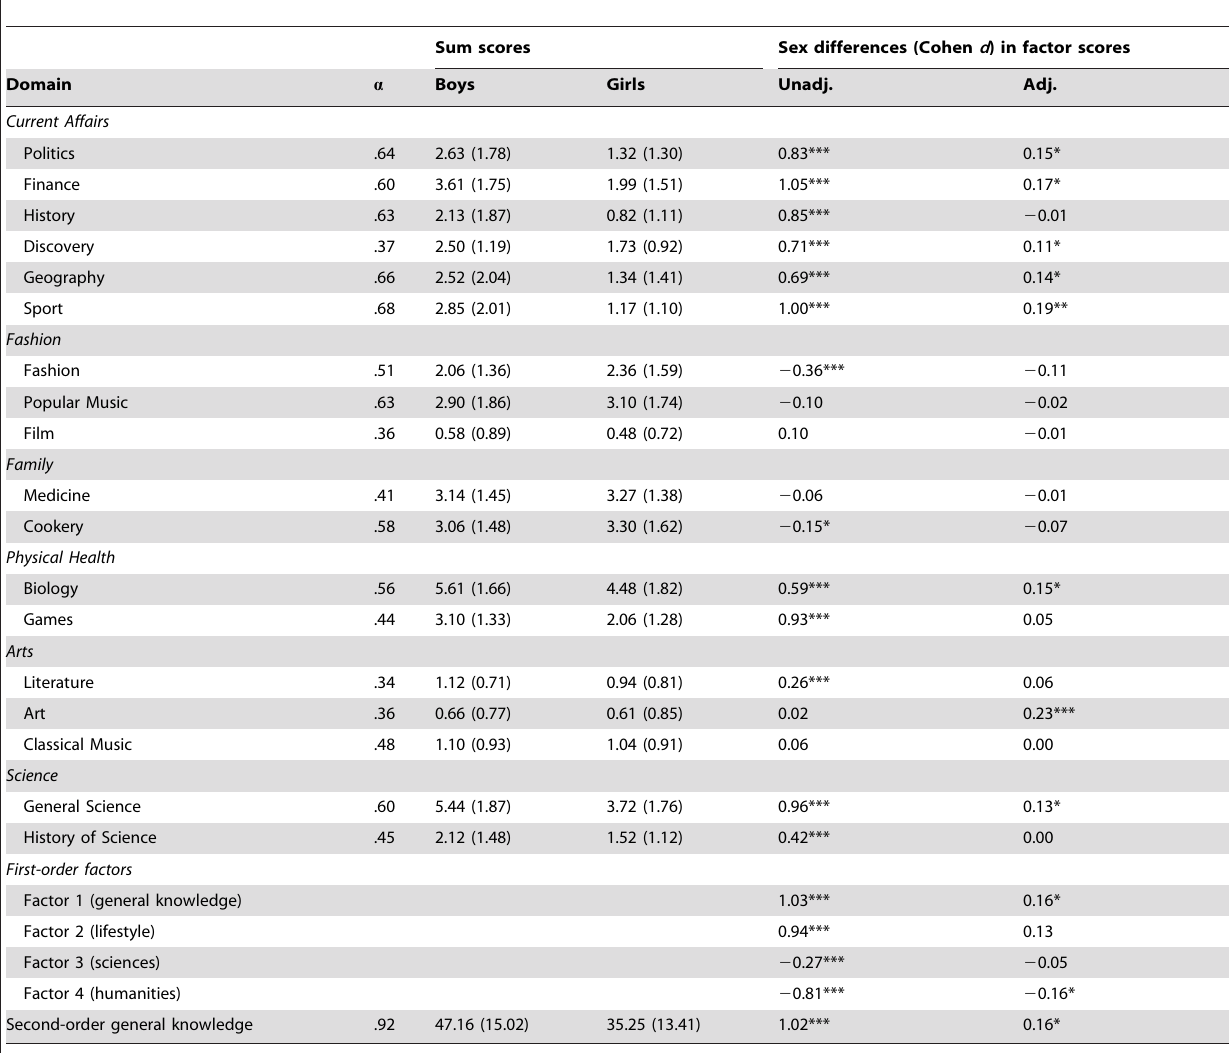
Table 5. Scale Reliabilities, Sum Score Means and Standard Deviations, and Sex Differences in Factor Scores, Unadjusted and Adjusted for